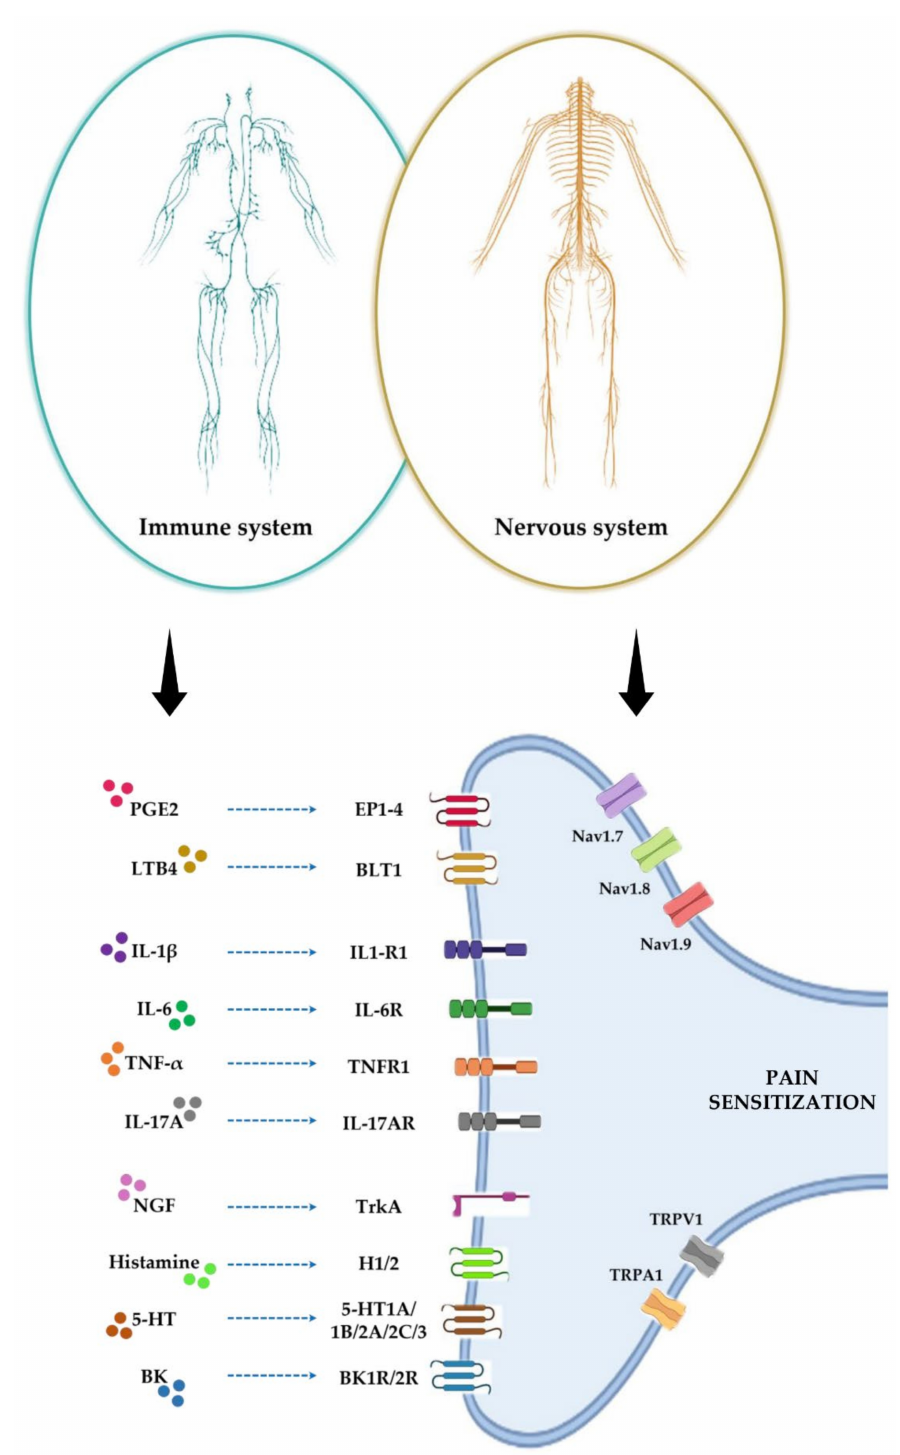
Figure 2. The pain development process occurs through a bidirectional crosstalk between immune cells and nociceptive neurons. During inflammation, cells of the immune system secrete a wide variety of molecular mediators responsible for nociceptive stimulation. These include lipid mediators, such as prostaglandin E2 (PGE2) and leukotriene B4 (LTB4); cytokines, such as interleukin-1 beta (IL1 β ), interleukin-6 (IL-6), tumour necrosis factor- α (TNF α ), and interleukin-17A (IL-17A); growth factors and neurotransmitters, such as nerve growth factor (NGF), histamine, serotonin (5-HT), and bradykinin (BK). All these mediators interact with their receptors on peripheral nerve terminals, causing sensitization to